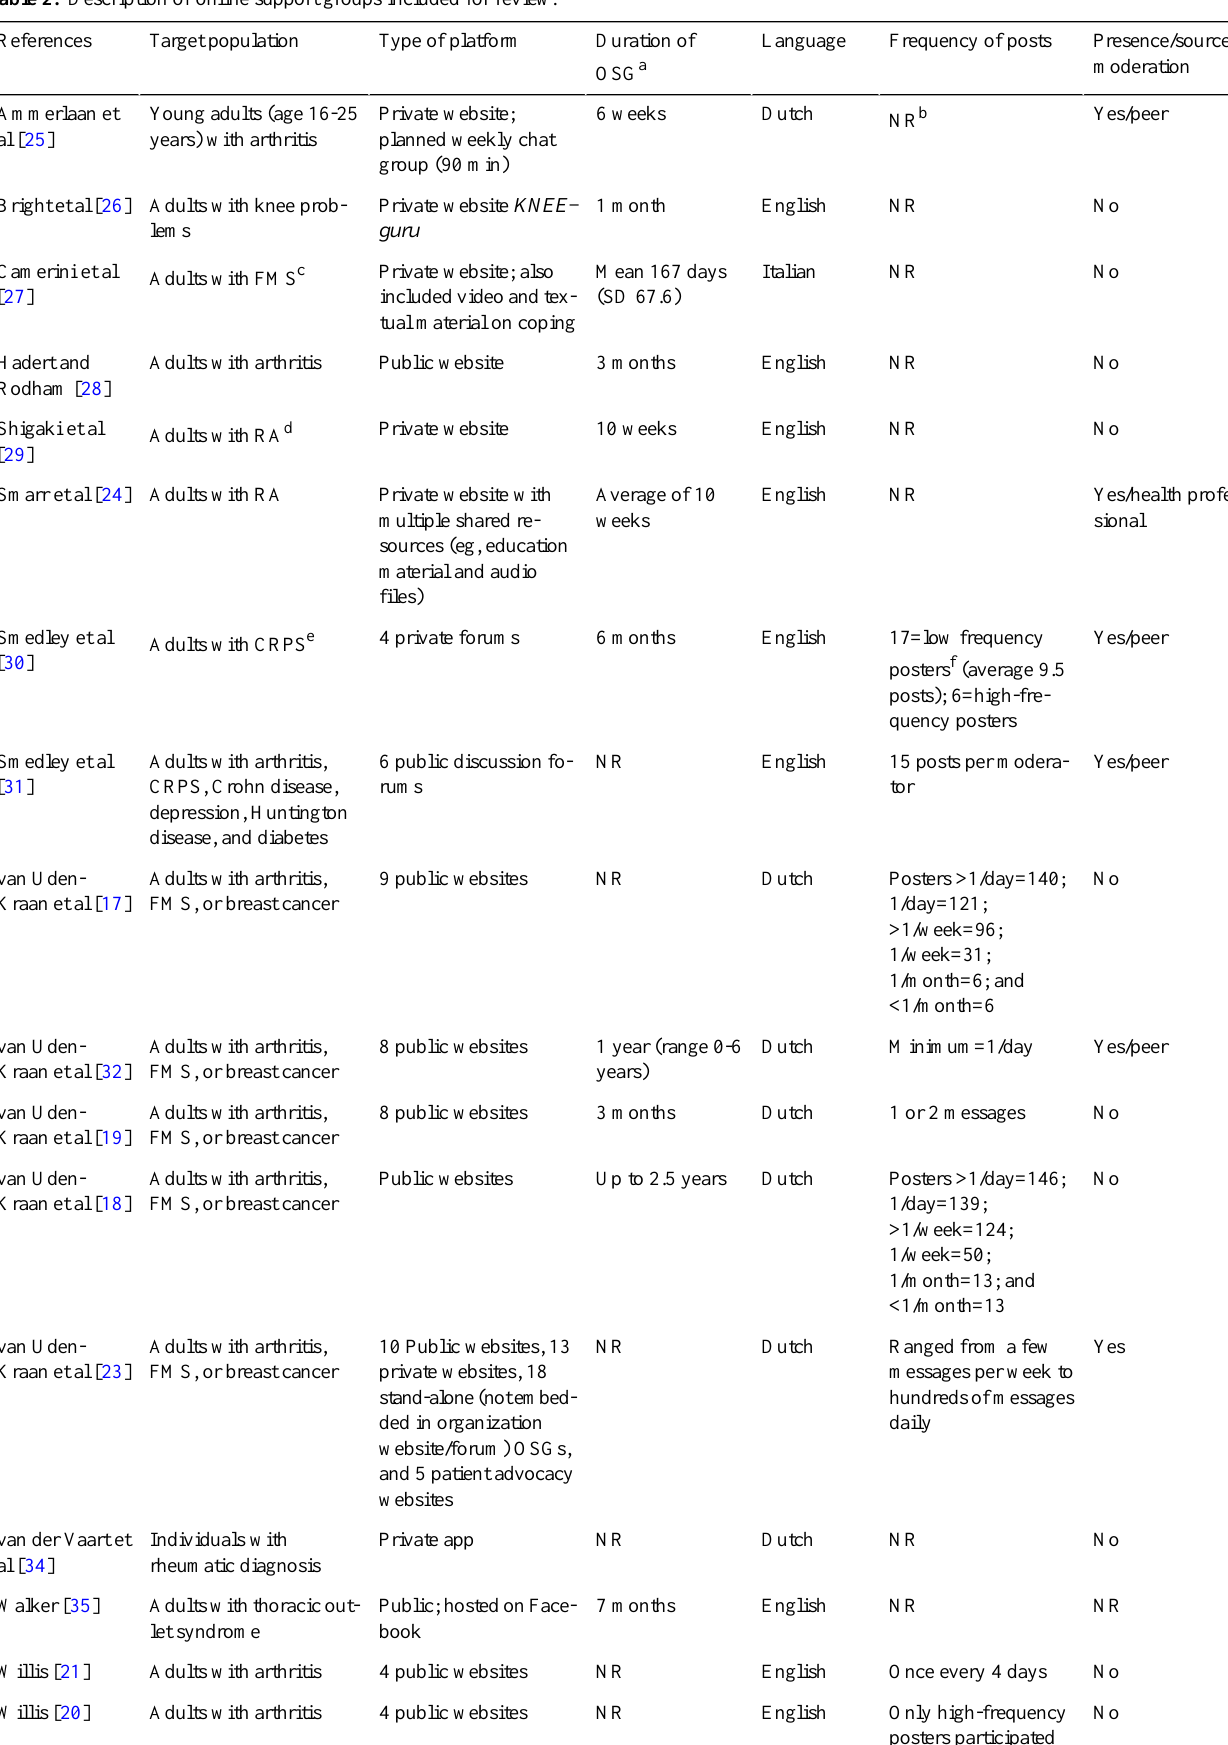
Table 2. Description of online support groups included for review.